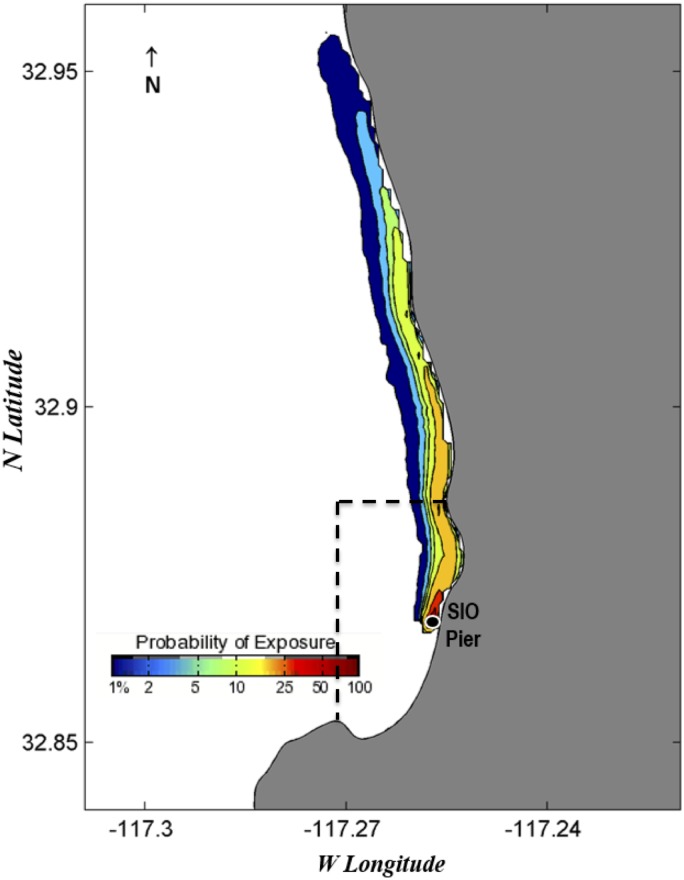
Probability map of predicted fish egg dispersal prior to collection: June 16–19, 2013.Dotted lines depict the boundaries of the MPAs: the San Diego-Scripps SMCA to the north and the Matlahuayl SMR to the south.